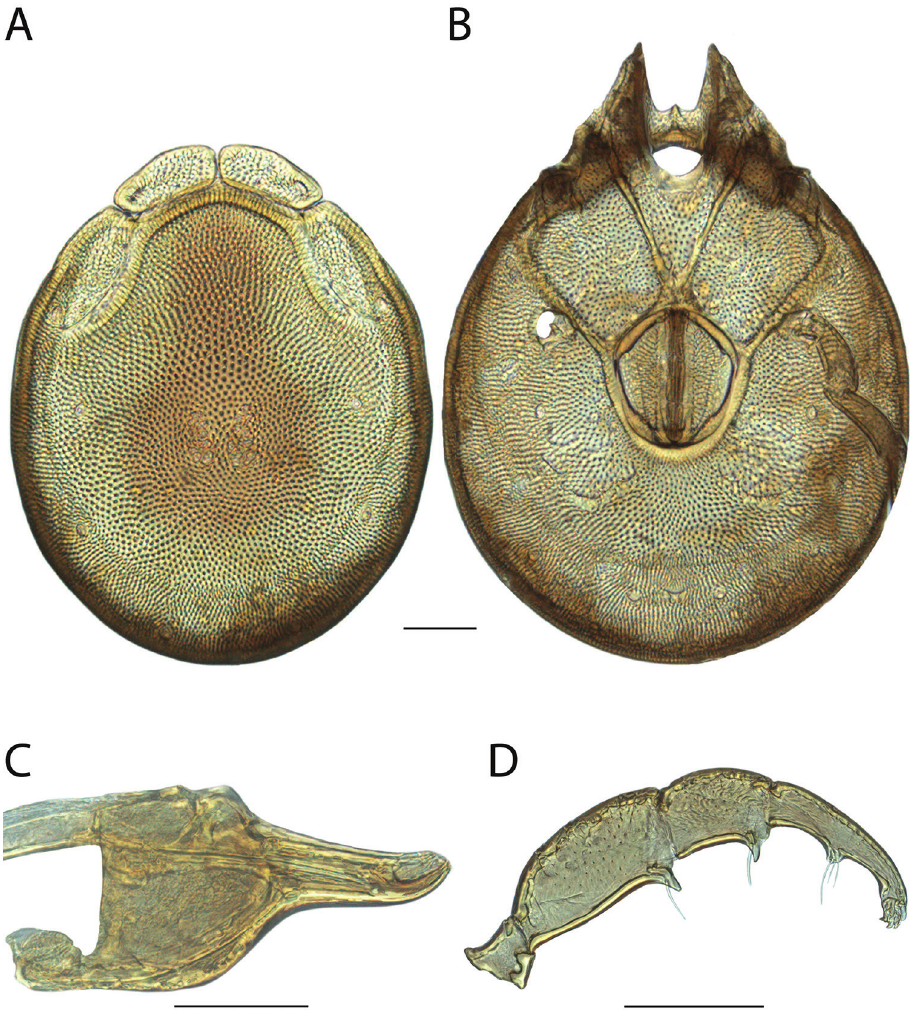
Figure 82. Torrenticola folkertsae sp. n. female: A dorsal plates B venter (legs removed) C subcapitulum D pedipalp (setae not accurately depicted). Scale = 100